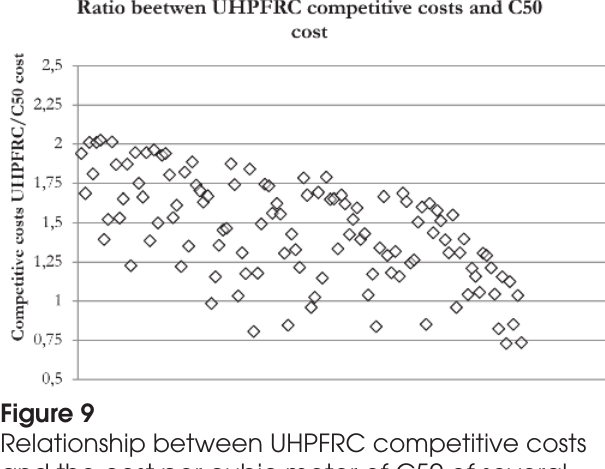
Figure 9 Relationship between UHPFRC competitive costs and the cost per cubic meter of C50 of several wind towers on the y axis. The x-axis refers to the numbering of the tower by design order (that remains implicit